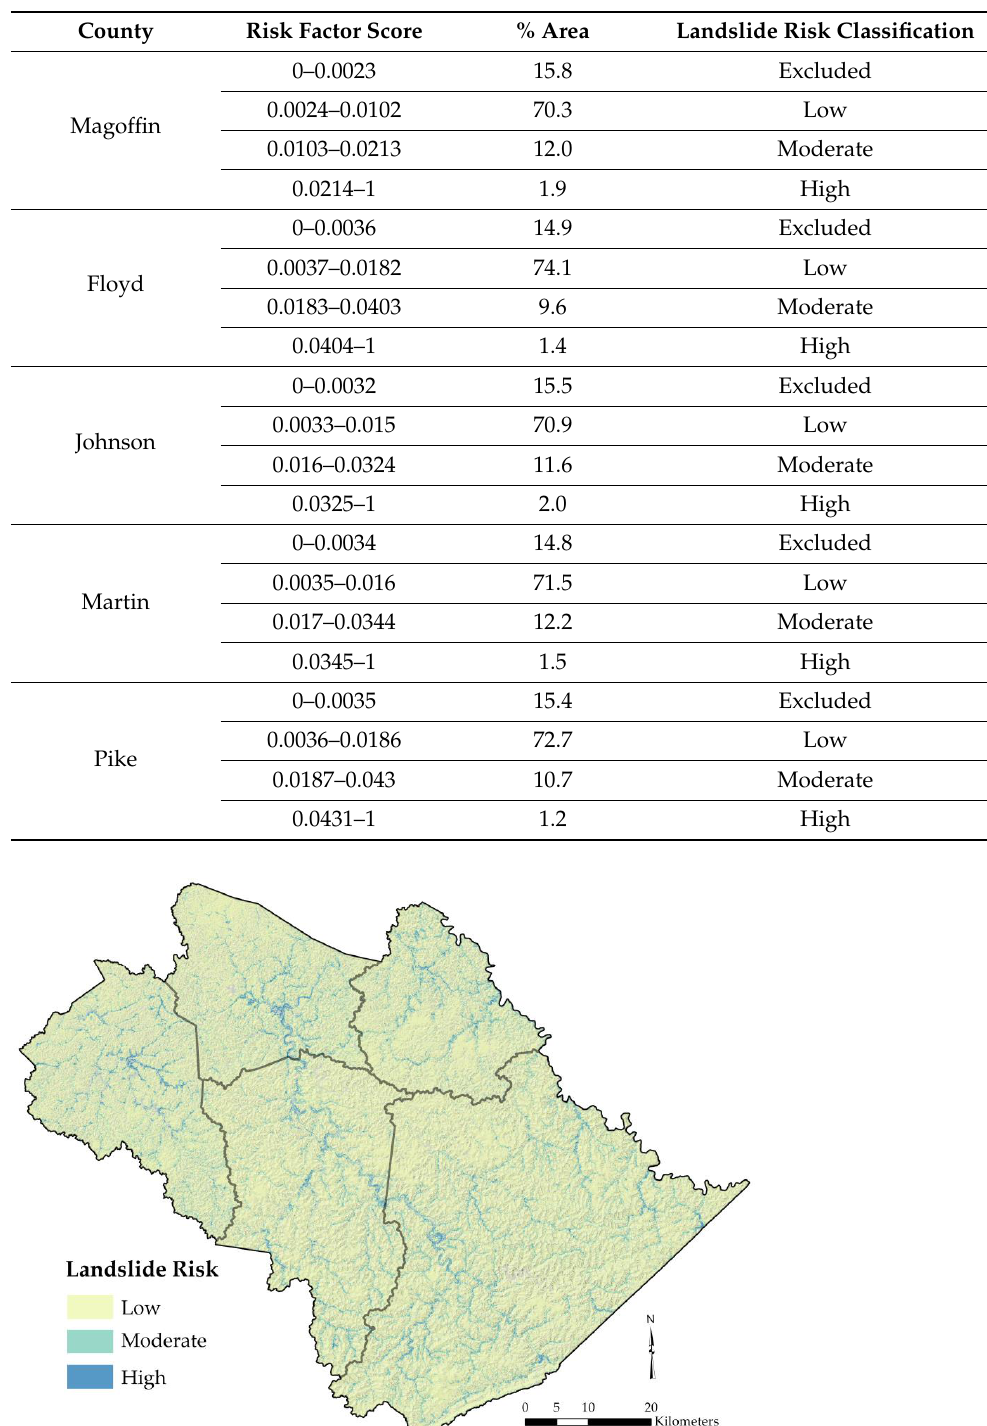
Table 6. Risk factor score and classification. The risk classification corresponds to Figure 10.